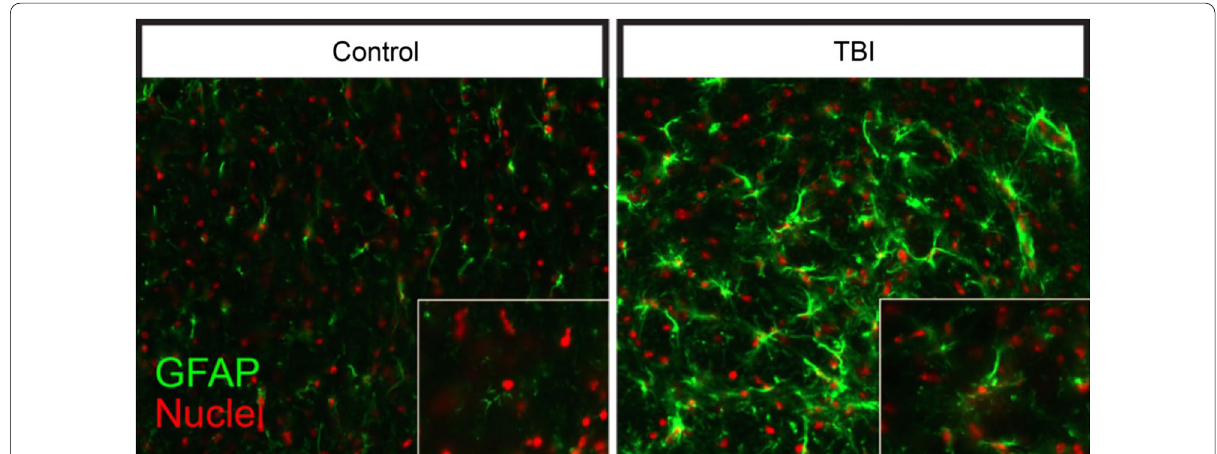
Fig. 3 Reactive astrogliosis after moderate severity TBI. Moderate severity TBI increases astrogliosis at 72 h after injury, as measured by GFAP